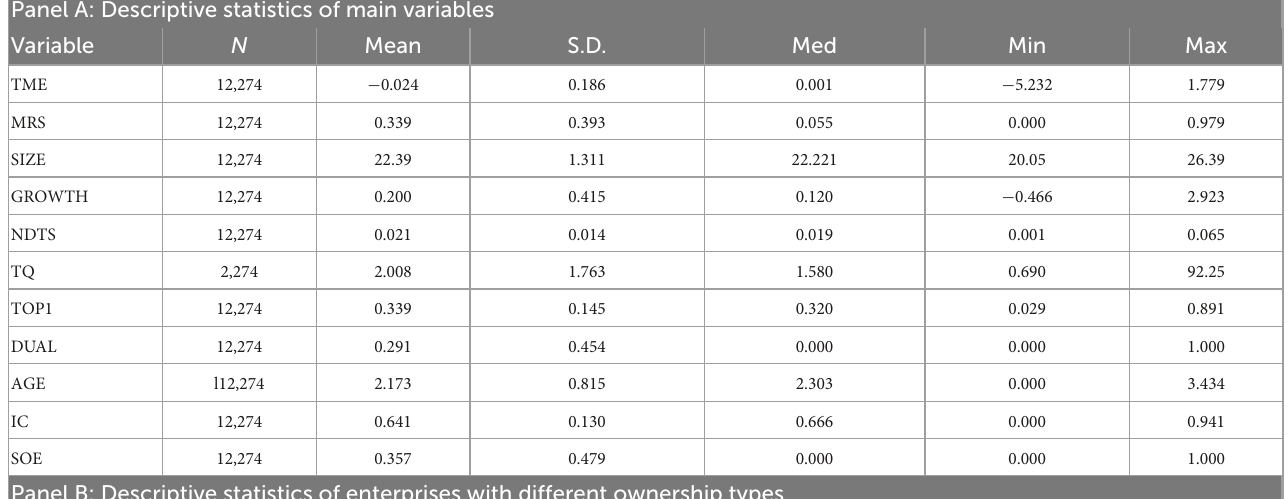
TABLE 3 Descriptive statistics and correlation